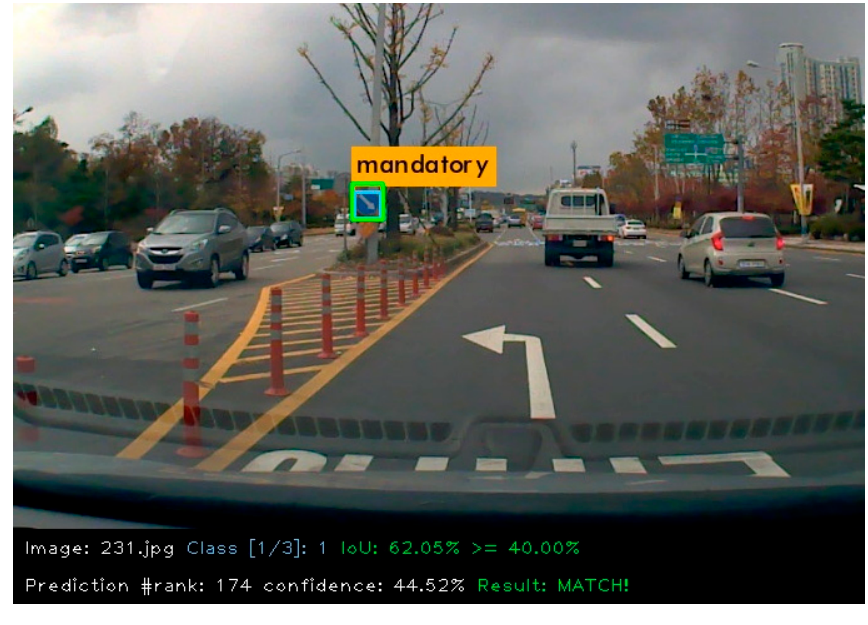
Figure 7. An IOU calculation example.